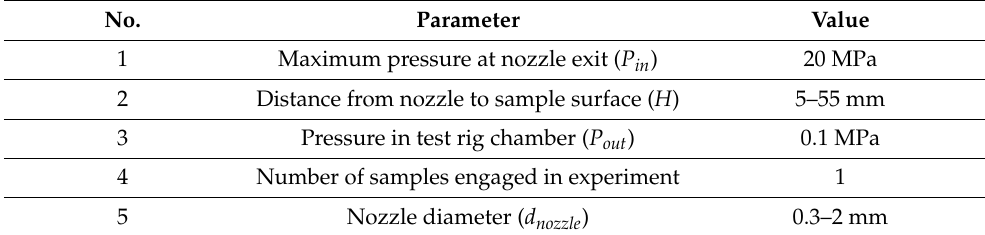
Table 1. Technical characteristics of the cavitation jet test